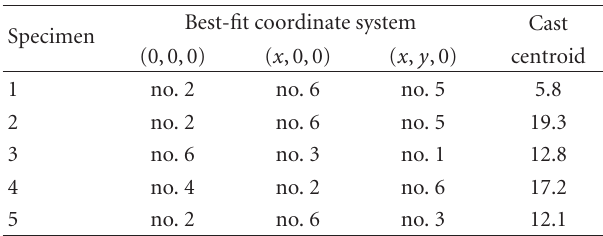
Table 2: The best-fit matching results in µ m of the number 2 through number 5 cast frameworks to their respective master casts using the fixed method of alignment and the vertical gap at the best positions.